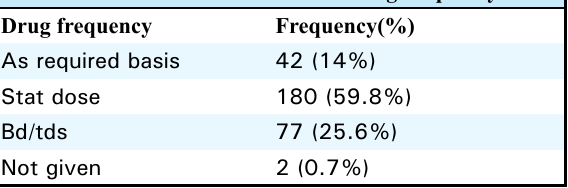
Table 4. Medication instruction for drug frequency.